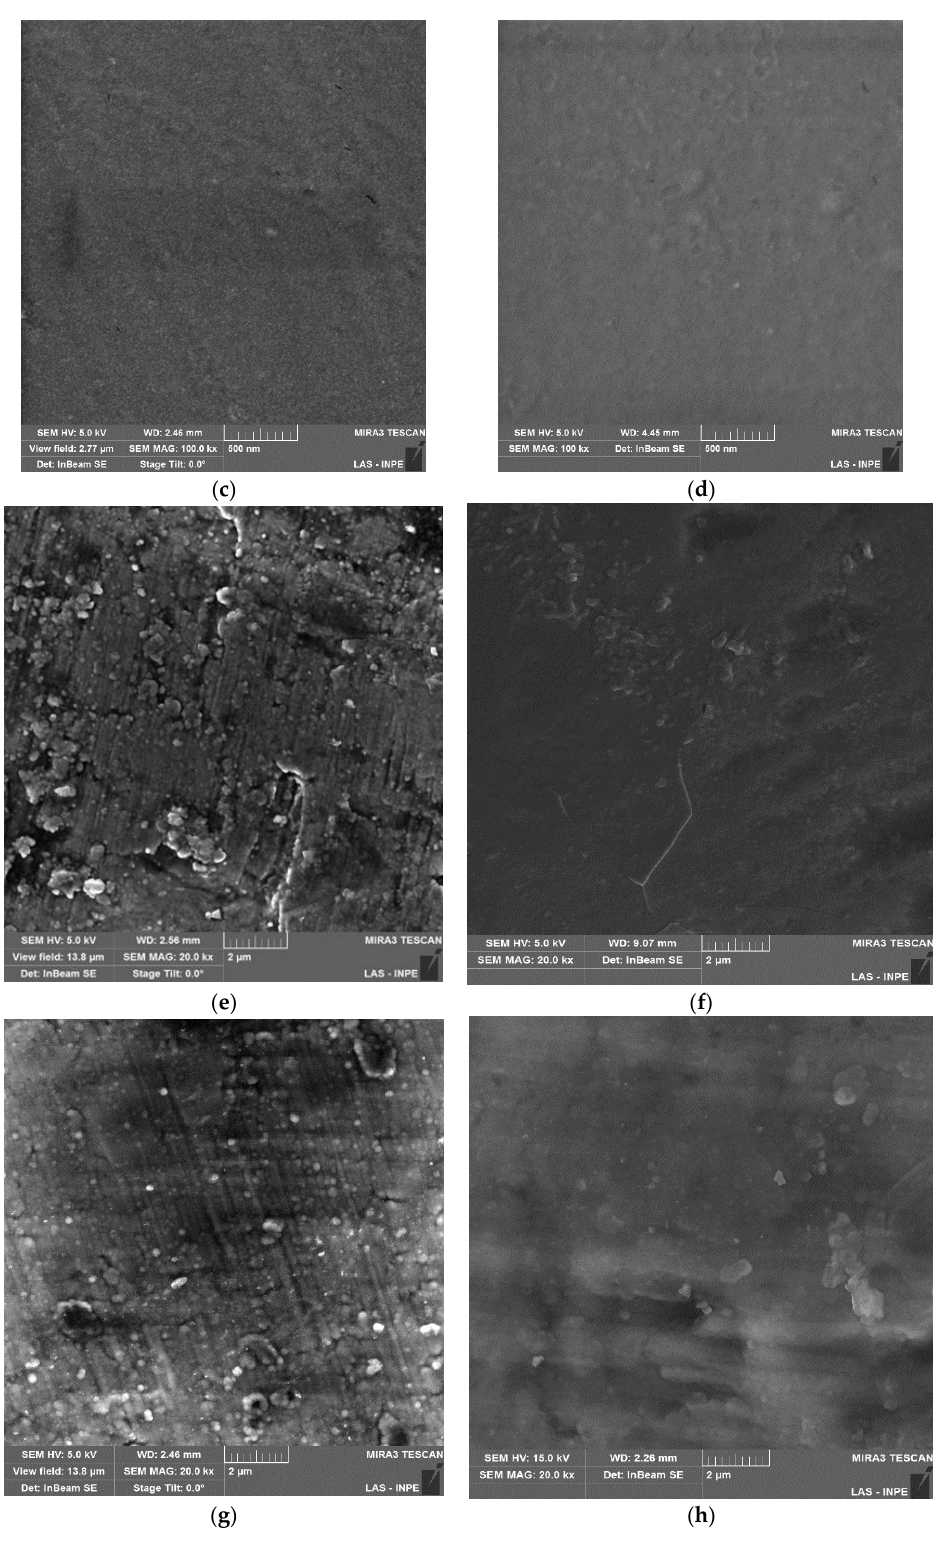
Figure 2. Scanning electron microscopy (SEM) micrographs of the studied samples: ( a ) bare Al ( b ) commercial resin-coated Al, ( c ) TiO 2 -coated Al, ( d ) Al 2 O 3 -coated Al, in the condition of as-deposited; ( e ) bare Al, ( f ) commercial resin-coated Al, ( g ) TiO 2 -coated Al, ( h ) Al 2 O 3 -coated Al in the condition after corrosion process. Here, the corrosion time of the samples was of 10